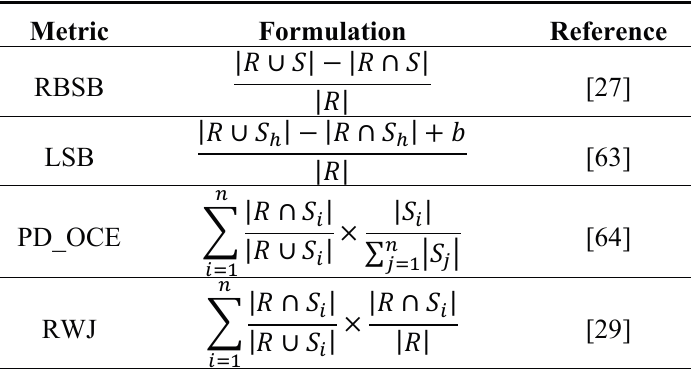
Table 1. The four spatial empirical discrepancy metrics used for segment evaluation, written using set theory